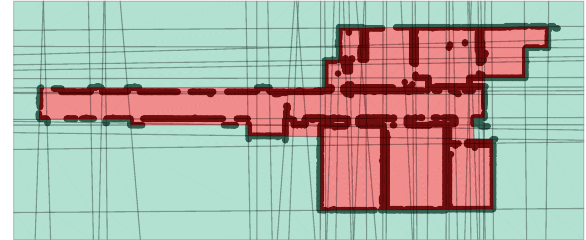
Figure 5. Identification of indoor and outdoor faces.